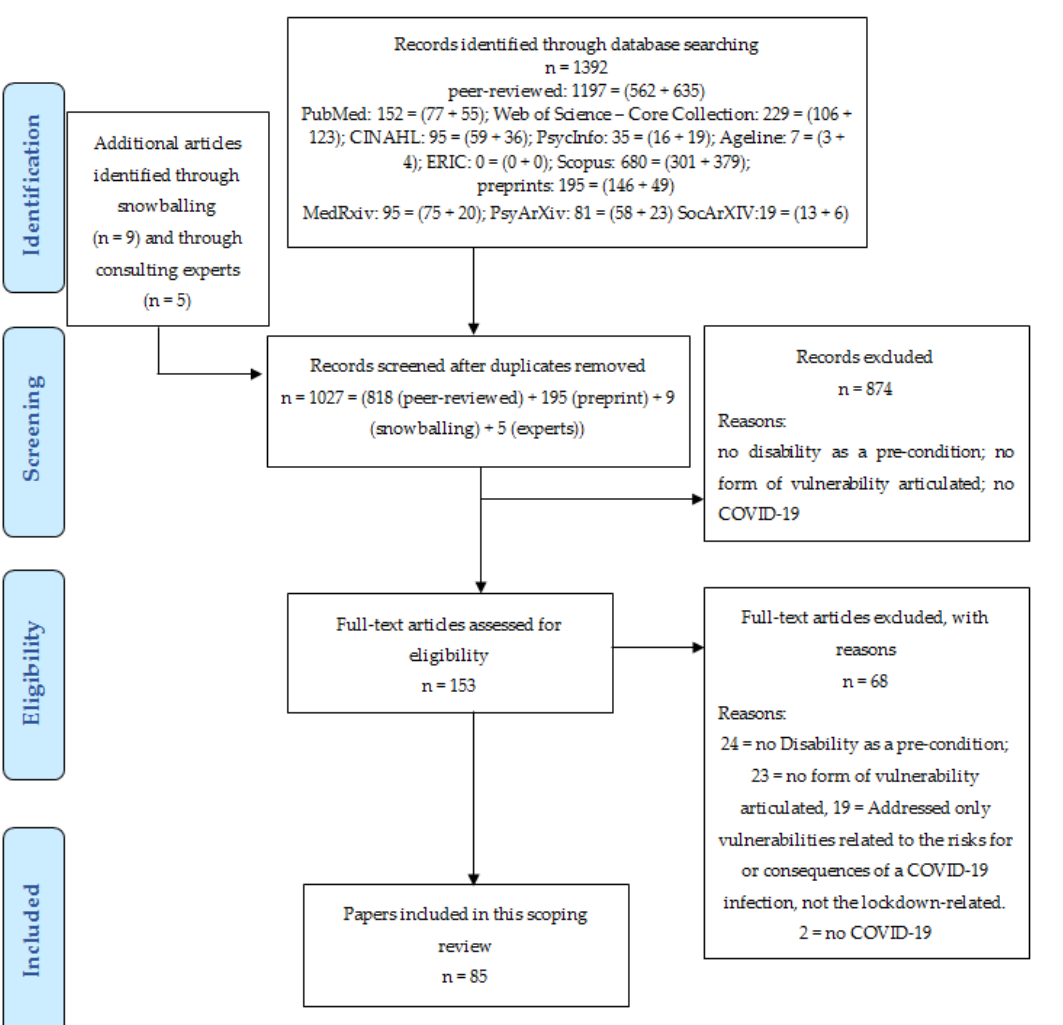
Figure 1. PRISMA flowchart of the scoping review with thematic